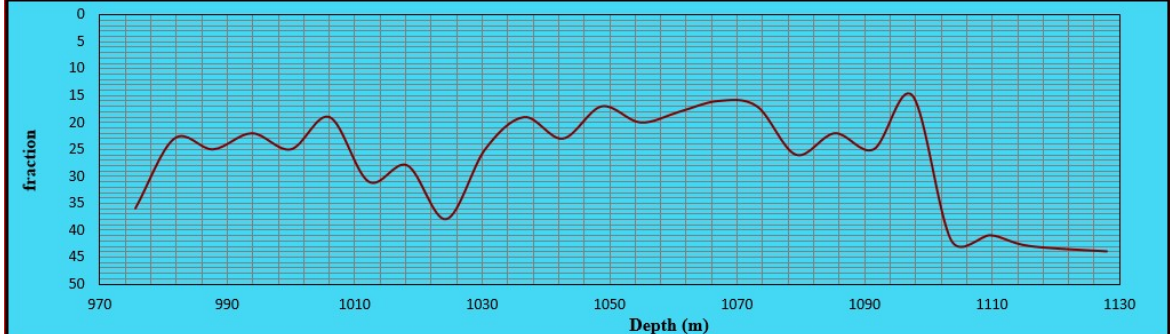
Figure 18. Neutron porosity variation along the depth.